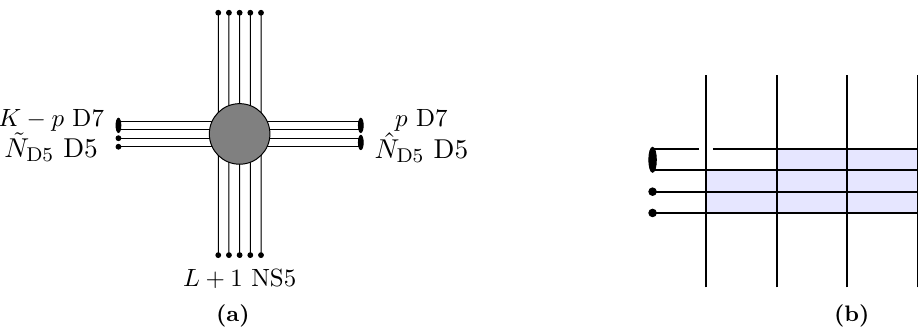
Figure 4 . Left: the junction shown in figure 3a after moving p D7-branes to the right and rotating their branch cuts accordingly. Right: the gauge theory of figure 3b. The broken lines are avoided intersections due to the s -rule. The closed (gauge theory) faces are